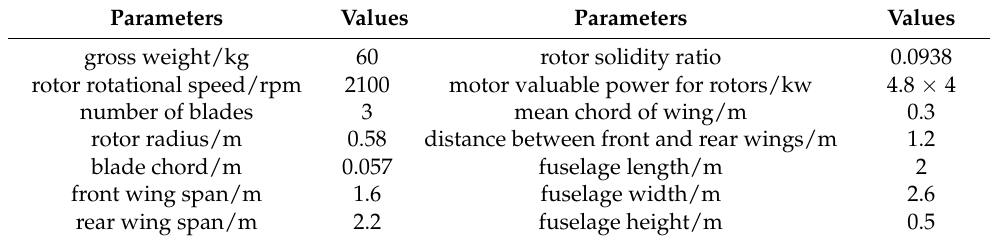
Table 1. General parameters of the quad tiltrotor.